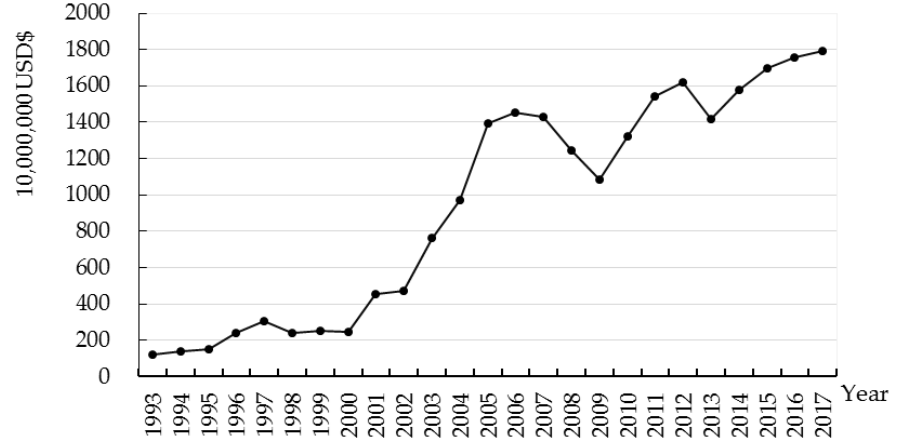
Figure 3. FDI in Zhejiang Province (1993 to 2017). Data source: Zhejiang Statistical Yearbook.